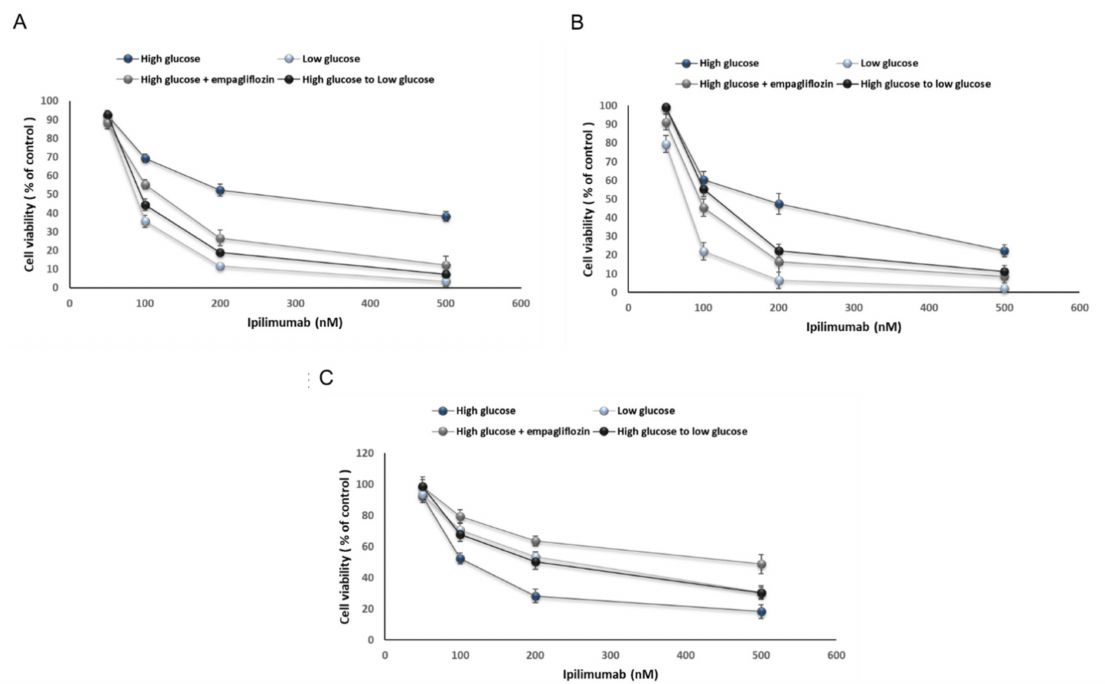
Figure 2. Cell viability of MCF-7 ( A ) and MDA-MB-231 ( B ) cells after 72 h of incubation with ipilimumab under di ff erent condition (high glucose; low glucose; high glucose + empagliflozin at 500 nM; switch high glucose to low glucose); ( C ) Cell viability of AC16 cells after 72 h of incubation with ipilimumab under di ff erent condition (high glucose; low glucose; high glucose + empagliflozin at 500 nM; shifting from a high glucose to low glucose). Error bars depict means ± SD ( n = 3). Statistical analysis was performed using paired t